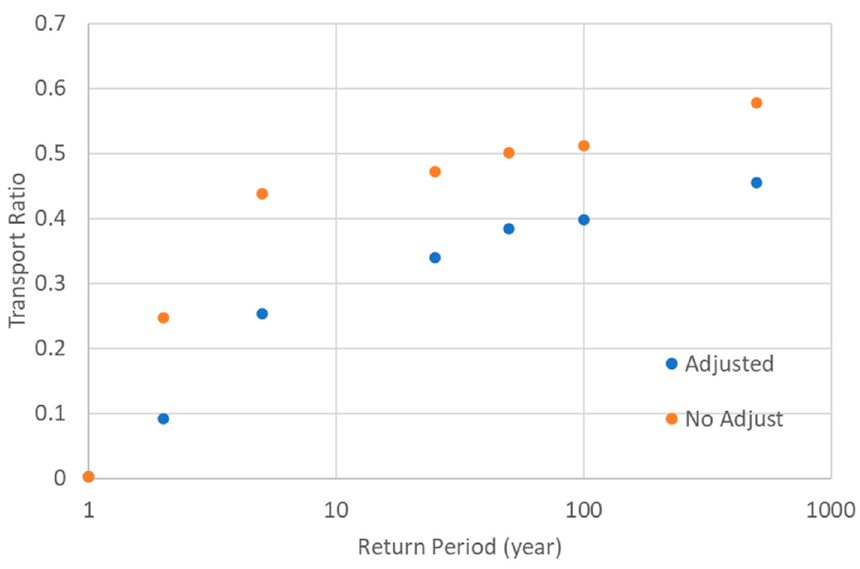
Figure 11. The total transport ratio of LWD as a function of hydrologic event return periods.